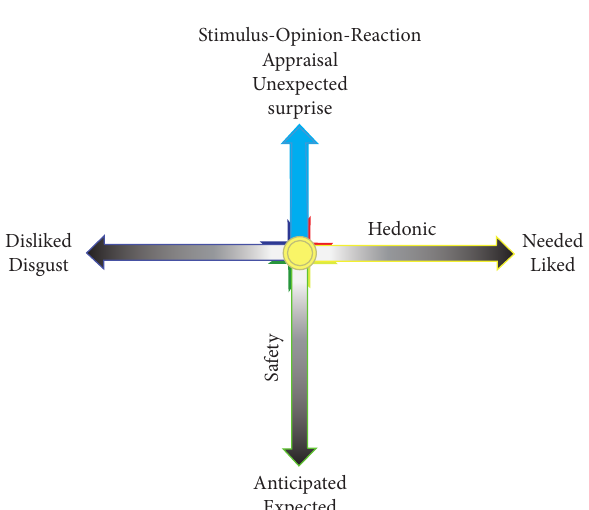
Figure 3: Stressful events are something that happened unexpectedly . Every stimulus has the hedonic value (horizontal dimension), which fits into our personal needs (pleasant things, needed things, or disliked things or unpleasant things). And it can happen in an expected way, or unexpected ways (vertical dimension), which are called safety value